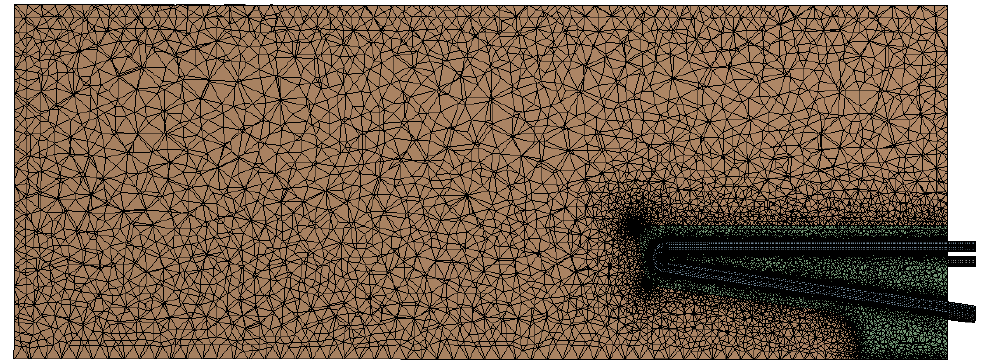
Figure 5. Mesh arrangement for the overall computational domain.